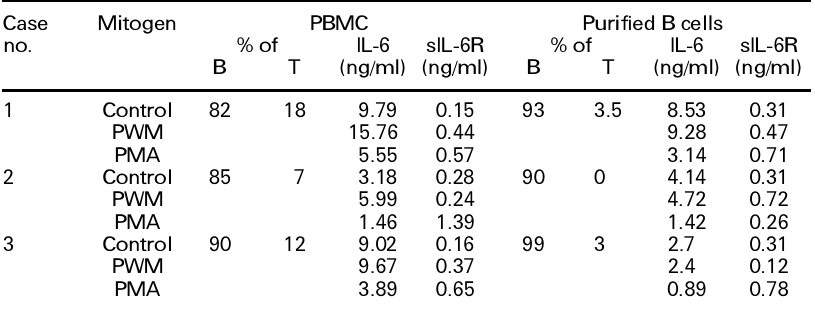
Table 2. Effect of puri® cation of B-CLL B cells stimulated with PMA or PWM on the levels of IL-6 and sIL-6R in supernatants of 5-day cultures a